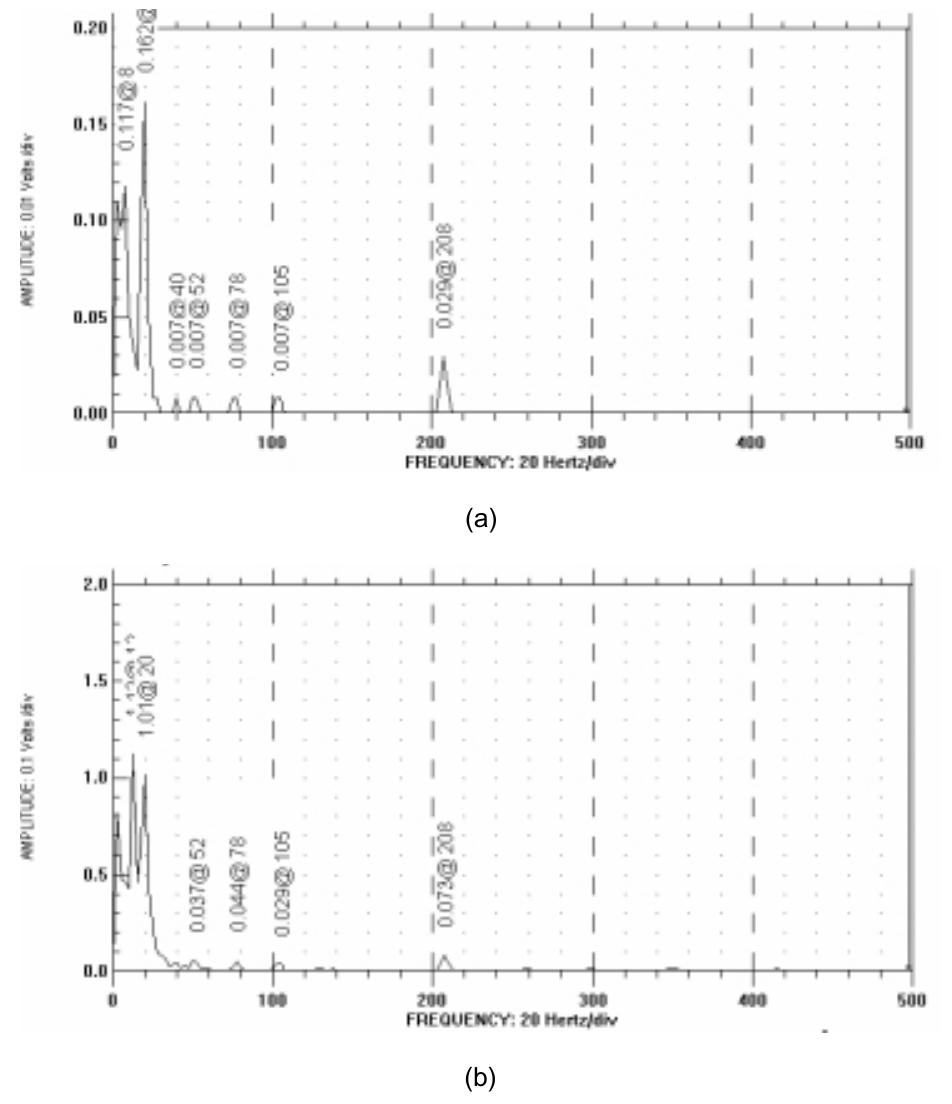
Fig. 31. Frequency spectrums of the steady-state vibrations of the system rotating at speed of 20 Hz: (a) Strain gages, (b) PZT material. 4. Finally, the free vibration test indicates that the PZT material embedded at the root of the blade has captured all frequency components produced by the strain gages and